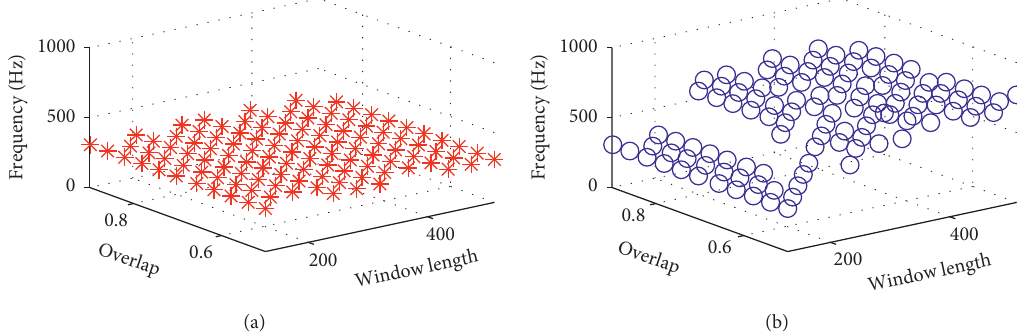
Figure 7: ICFs located by the proposed method and EFS of the simulated signal in Figure 6(b). (a) Envelope negentropy. (b) Energy fluctuation.